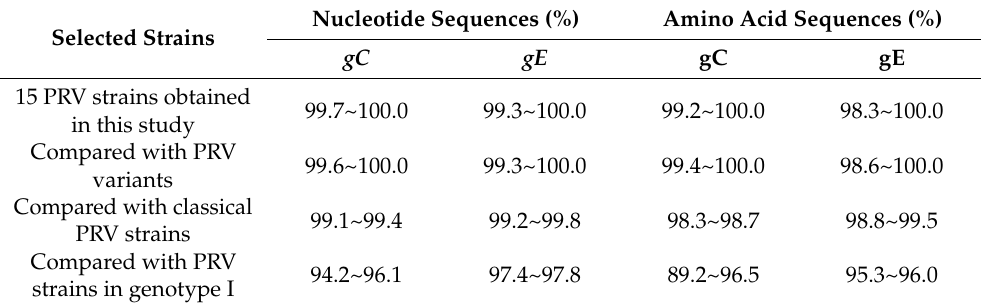
Table 4. Sequence similarity analysis of the gC and gE sequences of PRV strains identified in this